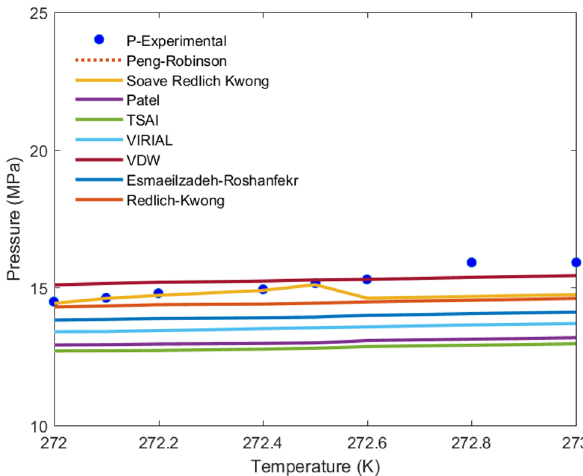
Fig. 11 Predicted pressure versus experimental plot for I – H – V phase region, AAD %, [Min/Max] of [2/16.4]